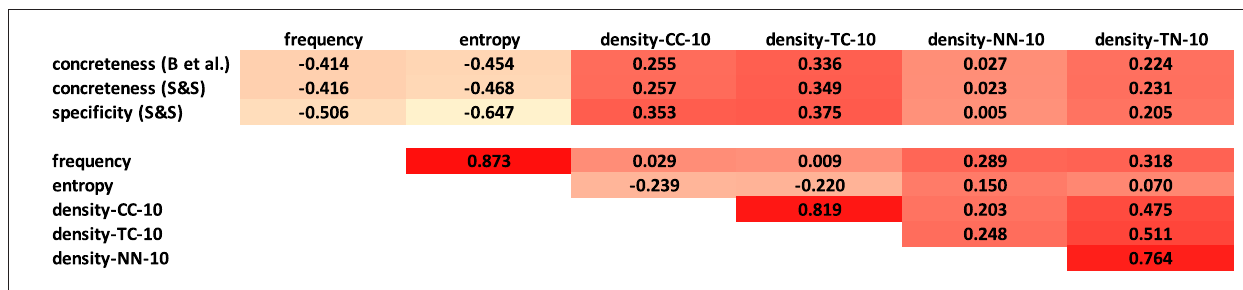
FIGURE 15 | Spearman’s ρ correlations between ratings and measures for the subset of 226 nouns in the intersection of Spreen and Schulz (1966) and Brysbaert et al. (2014).